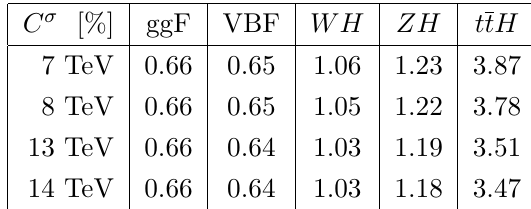
Table 3 . Coe(cid:14)cients parametrizing the corrections to the Higgs production cross sections due to loops involving the Higgs self-coupling (see eq. (A.13))